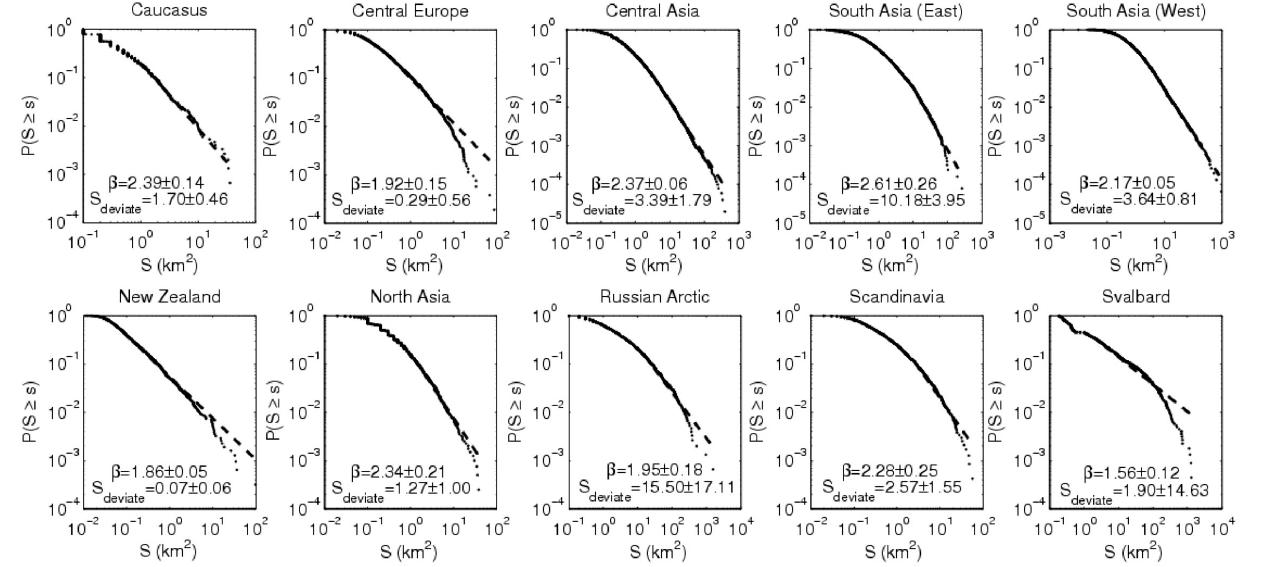
Fig. 1. The cumulative number–size distribution for 10 regions around the world. Only regions with greater than a 90% complete glacier inventory from Cogley (2009) are included. The location of each region is mapped in Fig. 2. The dashed line shows the power-law fit. The power-law scaling exponent β is shown for each region, as is the lower bound S deviate below which a power-law is not guaranteed by the data. Both β and S deviate are calculated using the statistical techniques outlined in Clauset et al. (2009). A weighted average of the regions gives β = 2 . 10 ± 0 . 09 and S deviate = 0 . 79 ± 4 . 98. Weights are the inverse of the error for each value of β and S deviate .